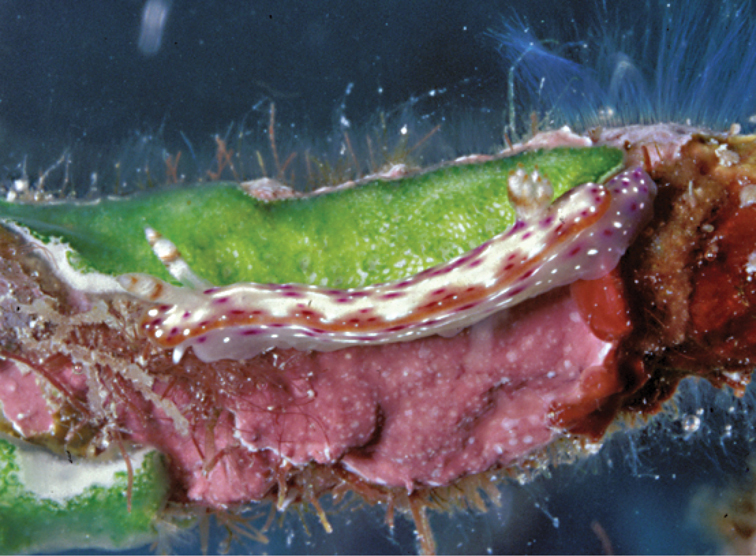
Hypselodoris maculosa, 15 mm, Maldives, photo: J Hinterkircher.